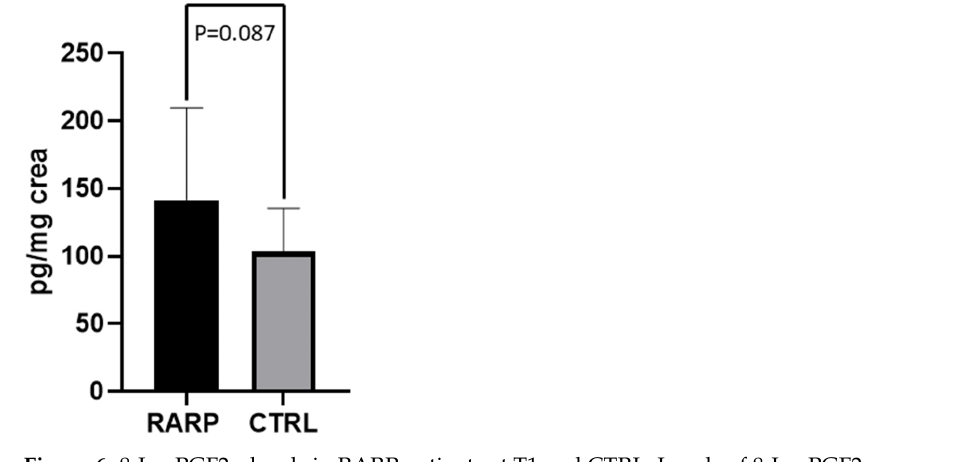
Figure 6. 8-Iso-PGF2 α levels in RARP patients at T1 and CTRL. Levels of 8-Iso-PGF2 α measured in urine from RARP patients at T1 and CTRL subjects. Data are represented as means ± SD.